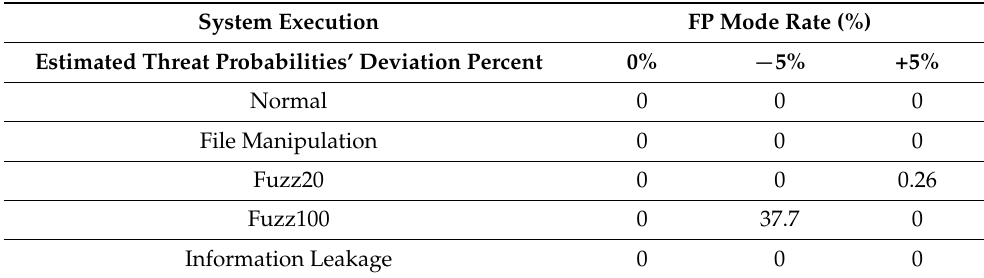
Figure 13. Simulation results plotting the insulin pump dynamic risk vs. execution time for +/ − 5% error in estimated threat probabilities for: ( a ) normal execution and ( b ) compromised execution with real malware. Table 5. False-positive mode rate for system execution with ± 5% estimation